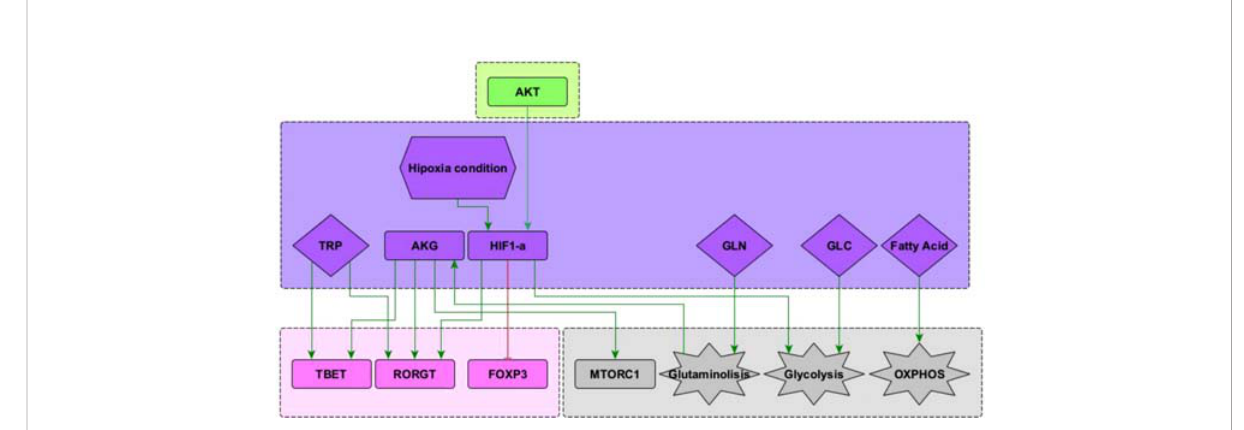
FIGURE 3 Subnetwork showing interaction of the nodes representing HIF1- a , glutamine (GLN), glucose (GLU), and fatty acids included in the network. See “ Network inference ” section for description. Subnetworks for other interactions of T-bet, ROR g T and Foxp3 nodes can be seen in (10). Subnetworks for other interactions of the mTORC1, glycolysis and OXPHOS nodes can be seen in Mart ı ́ nez-Me ́